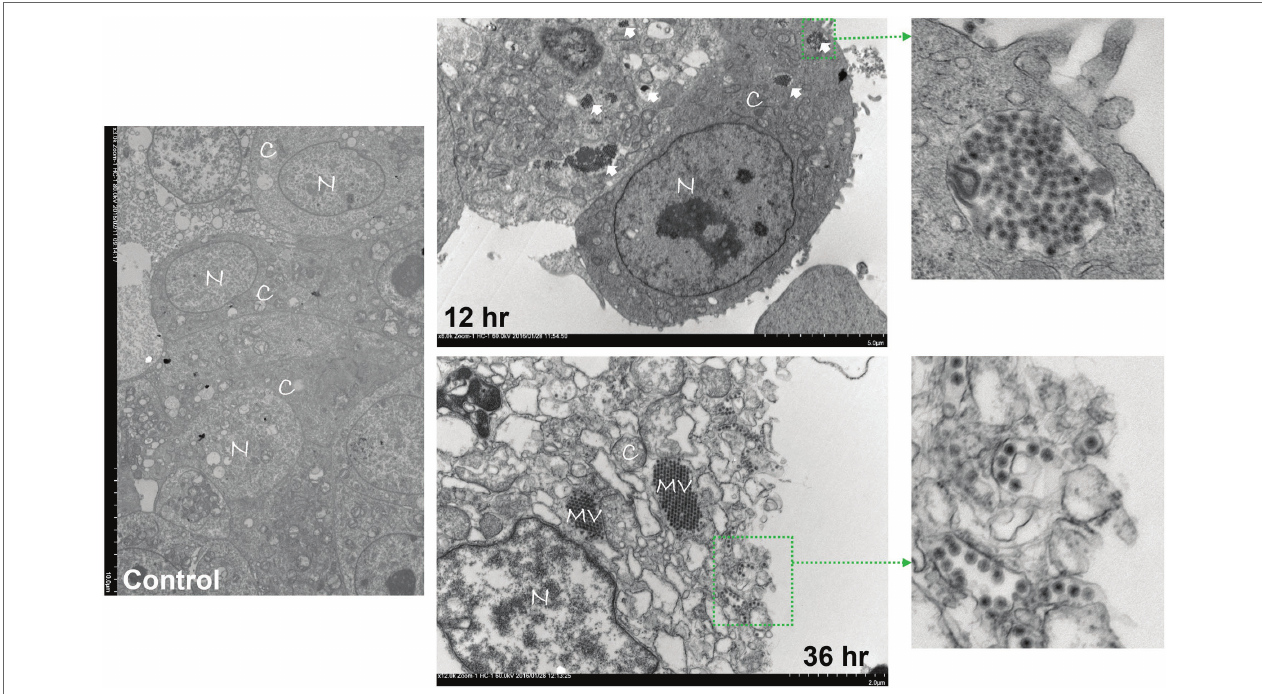
FIGURE 1 | Transmission electron microscopy (TEM) of control or ARV infected Leg horn hepatoma (LMH) cells at 12 and 36 h post-infection. C: cytoplasm, N: nucleus, MV: mature virions forming paracrystalline structures, Solid arrows: double membraned ARV neo-organelles, Broken arrows: directed release of mature virions via membranous